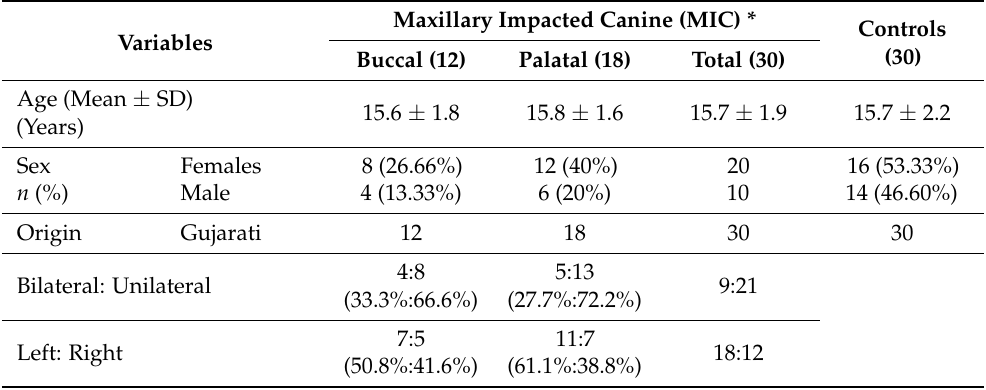
Table 2. Descriptive Statistics of Study groups.